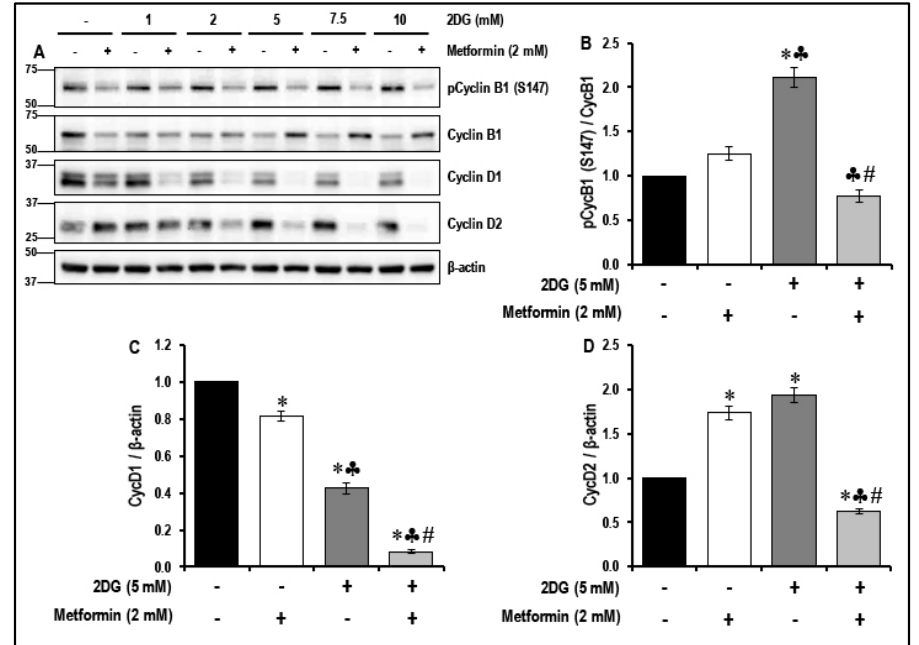
Figure 4. The levels of phosphorylated cyclin B1 (pCycB1; S147), cyclin D1 (CycD1) and cyclin D2 (CycD2) in metformin treated normal glucose- and 2DG-exposed MMECs (48 h): Representative Western blots ( A ) shows the levels of pCycB1 (S147), CycB1, Cyc D1 and D2 in cells treated with varying concentrations of 2DG in the presence or absence of metformin (2 mM), after 48 h in culture. Non-treated cells and cells treated with metformin (2 mM) alone were used as suitable controls. Bar graphs represent the ratio of (normalized against β -actin loading controls) pCycB1 (S147)/CycB1 ( B ), CycD1/ β -actin ( C ) and CycD2/ β -actin ( D ) in the cells treated with 2DG (5 mM) with or without metformin (2 mM), after 48 h in culture. * p < 0.05 indicates significance when compared to non-treated controls, ♣ p < 0.05 indicates significance when compared to control + 2 mM metformin-treated cells and # p < 0.05 indicates significance when compared to 2DG (5 mM)-treated cells. Treatment of MMECs with 2DG (5 mM) alone significantly increased ( ∼ 2.1-fold, * p < 0.05, Figure 4A,B) the levels of phosphorylated cyclin B1 (pCycB1; S147) when compared to non-treated cells.